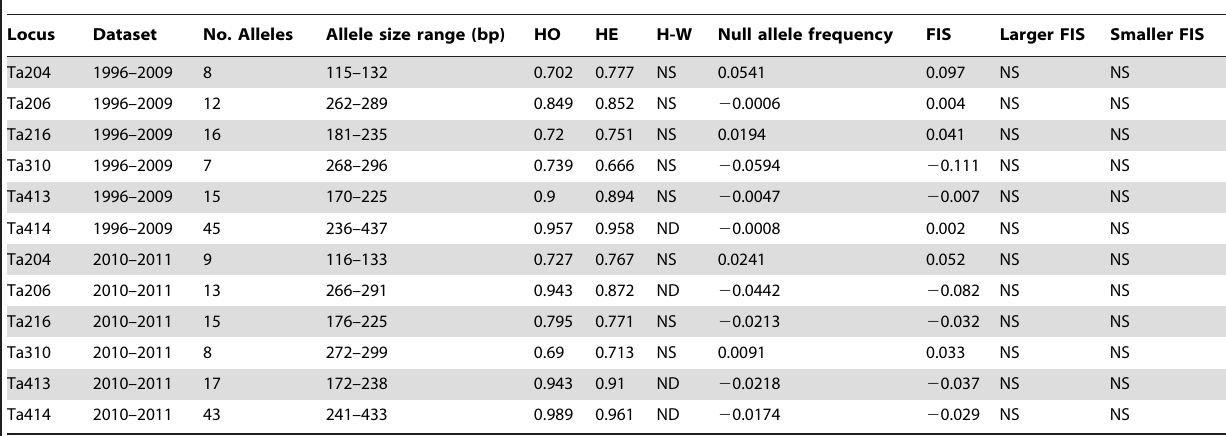
Table 1. Summary statistics in the adult barn owl population for all six microsatellite loci.